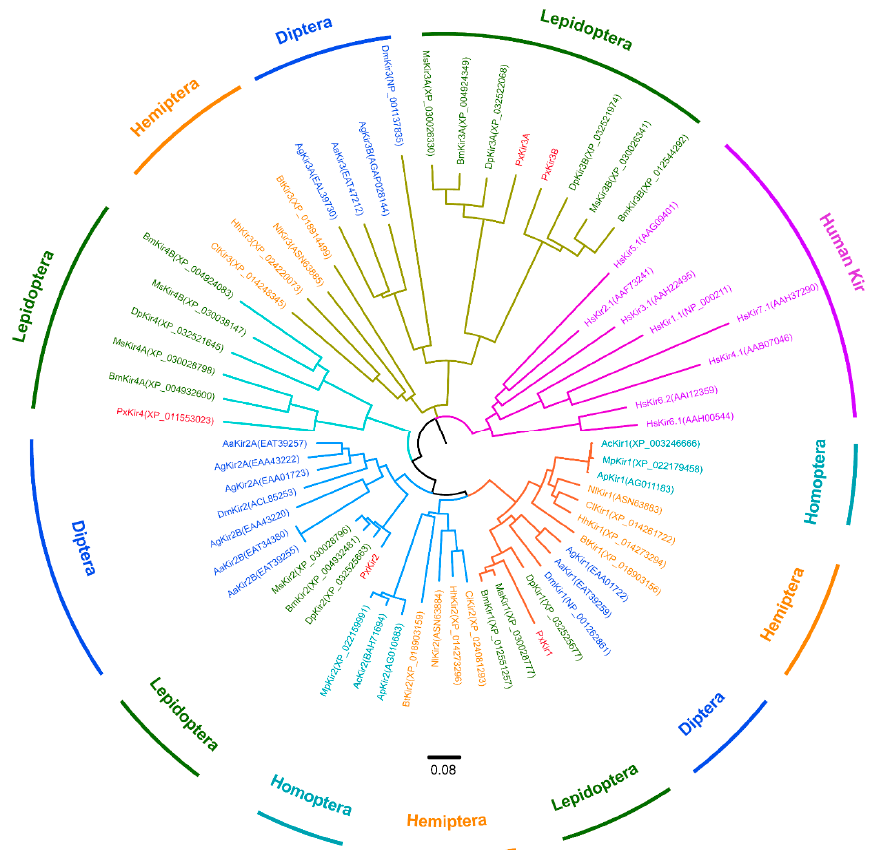
Figure 1. Phylogenetic analysis of PxKirs and various Kir subunits. Neighbor-joining tree showing the phylogenetic relationships of insect and human Kir channels (according to their amino-acid sequences). MEGA 7 was used to construct the tree (the neighbor-joining method was used; bootstrap test used 1000 replicates; model; amino: Poisson correction; gaps and treatment by pairwise deletion). The PxKir subunit is indicated with red color. GenBank accession numbers of Kir proteins are shown in